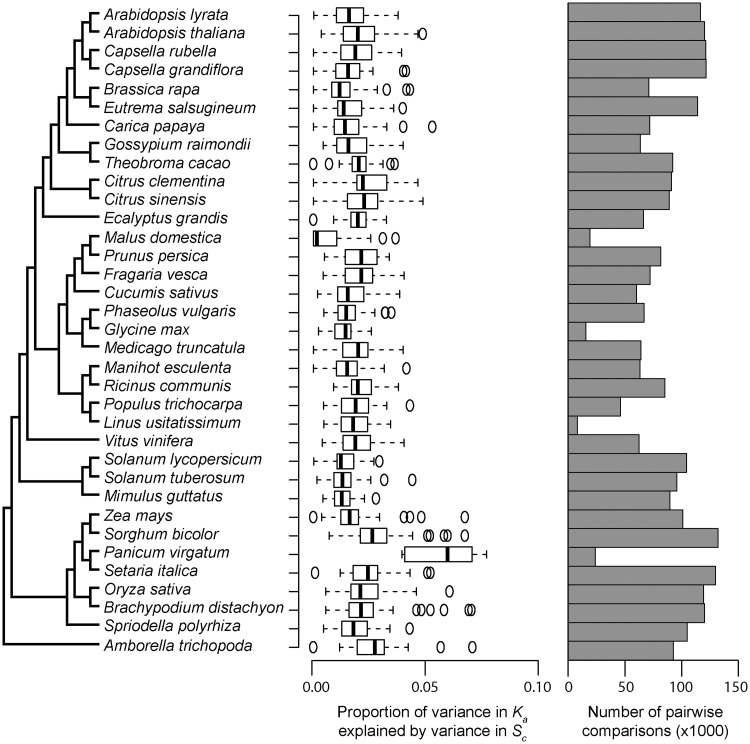
The strength of selection acting on transcript biosynthesis cost constrains the rate of amino acid sequence evolution. Gray bars depict mean values estimated from all possible pairwise comparisons featuring the species under consideration. Phylogenetic tree adapted from Phytozome (Goodstein et al. 2012).